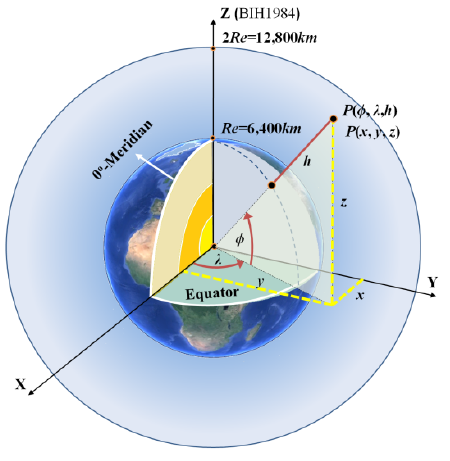
Fig. 1 The conceptual spheroid and definitions of its